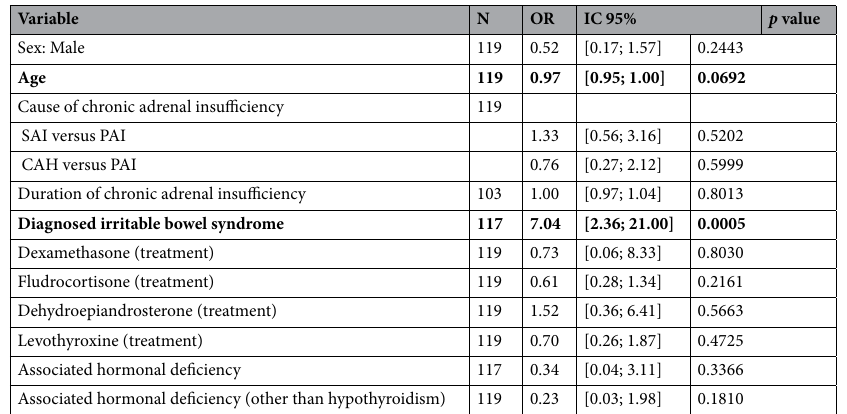
Table 2. Risk factors for abdominal pain (univariate analysis). Bold values represent variables with p -value < 0.2 that are included in the construction of the multivariate model. SAI secondary